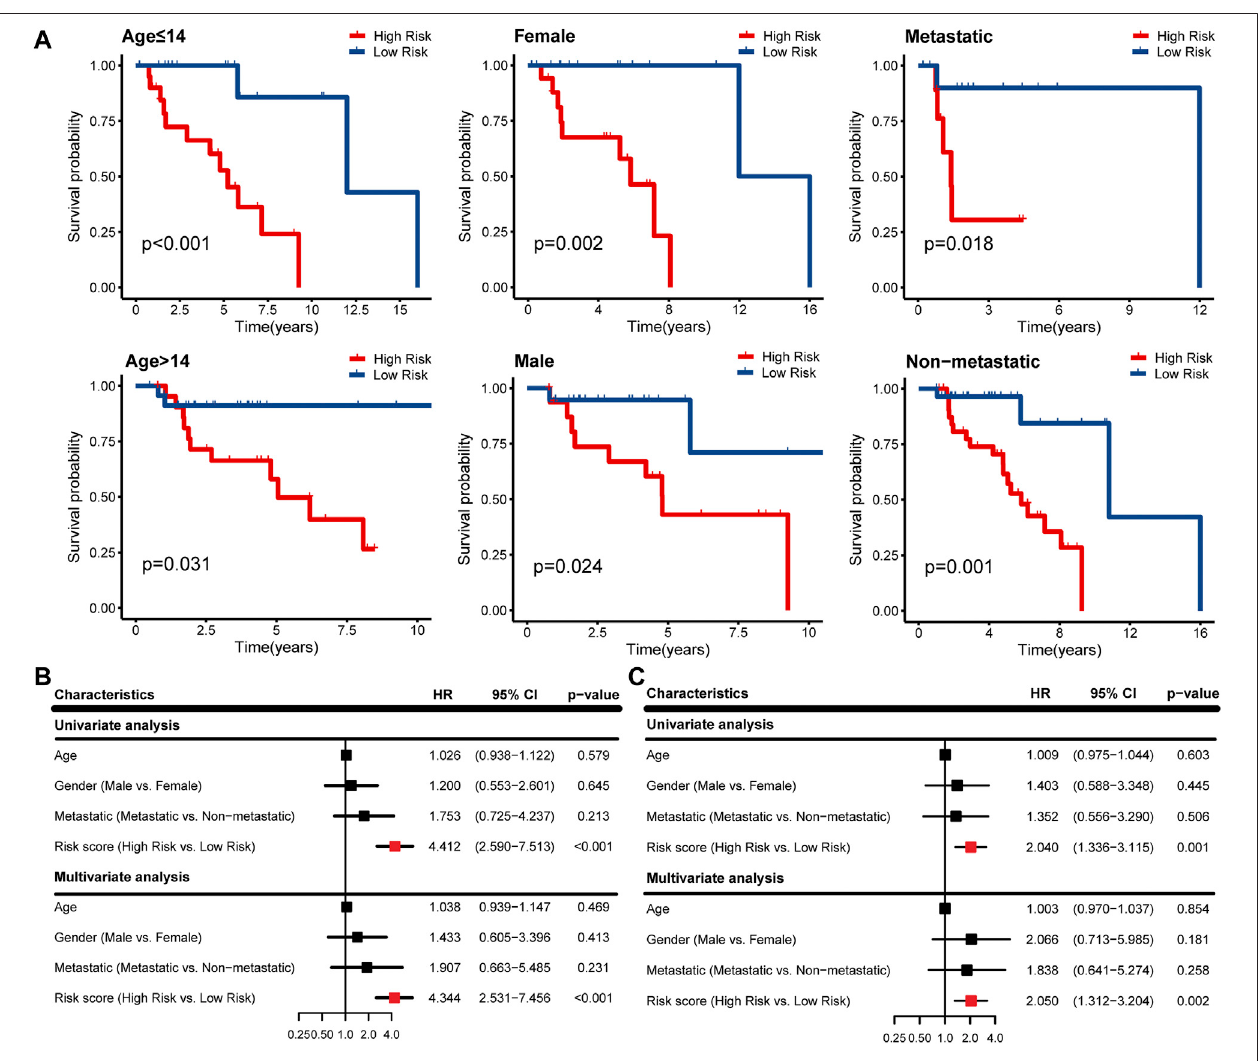
FIGURE4| Survivalanalysis ofIRPS with differentclinical characteristics and evaluation ofindependent prognostic factors. (A) Strati fi ed analysistoinvestigate the prognostic value of IRPS in the TARGET cohort. Univariate and multivariate Cox regression analysis in the (B) TARGET cohort and (C) GSE21257 cohort.